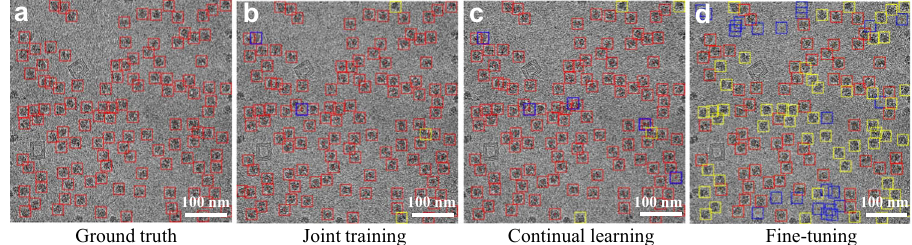
Fig. 3 Illustration of the catastrophic forgetting. The picked particles of 80S ribosome (EMPIAR-10028) are annotated by square boxes. The red, blue, and yellow boxes indicate the particles were correctly picked, wrongly picked, and missed, respectively. a The ground truth. b The results of the joint training model. c The results of the continual learning model. d The results of the fi ne-tuning model.